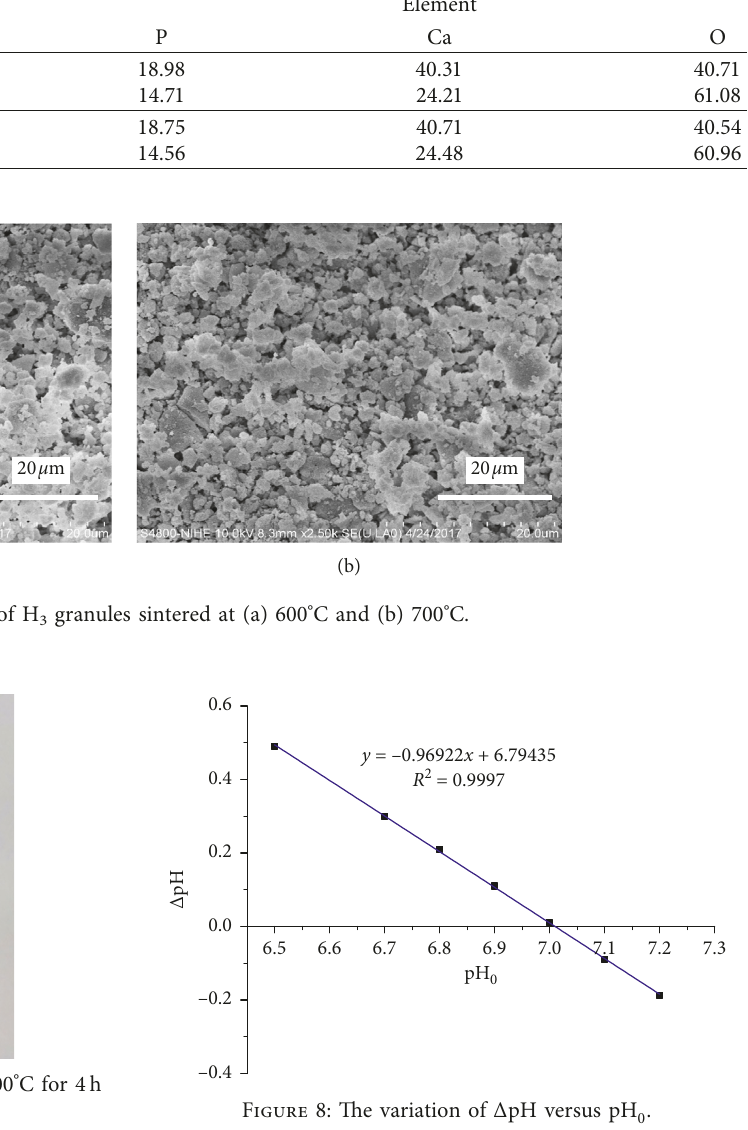
pH versus pH 0 Δ